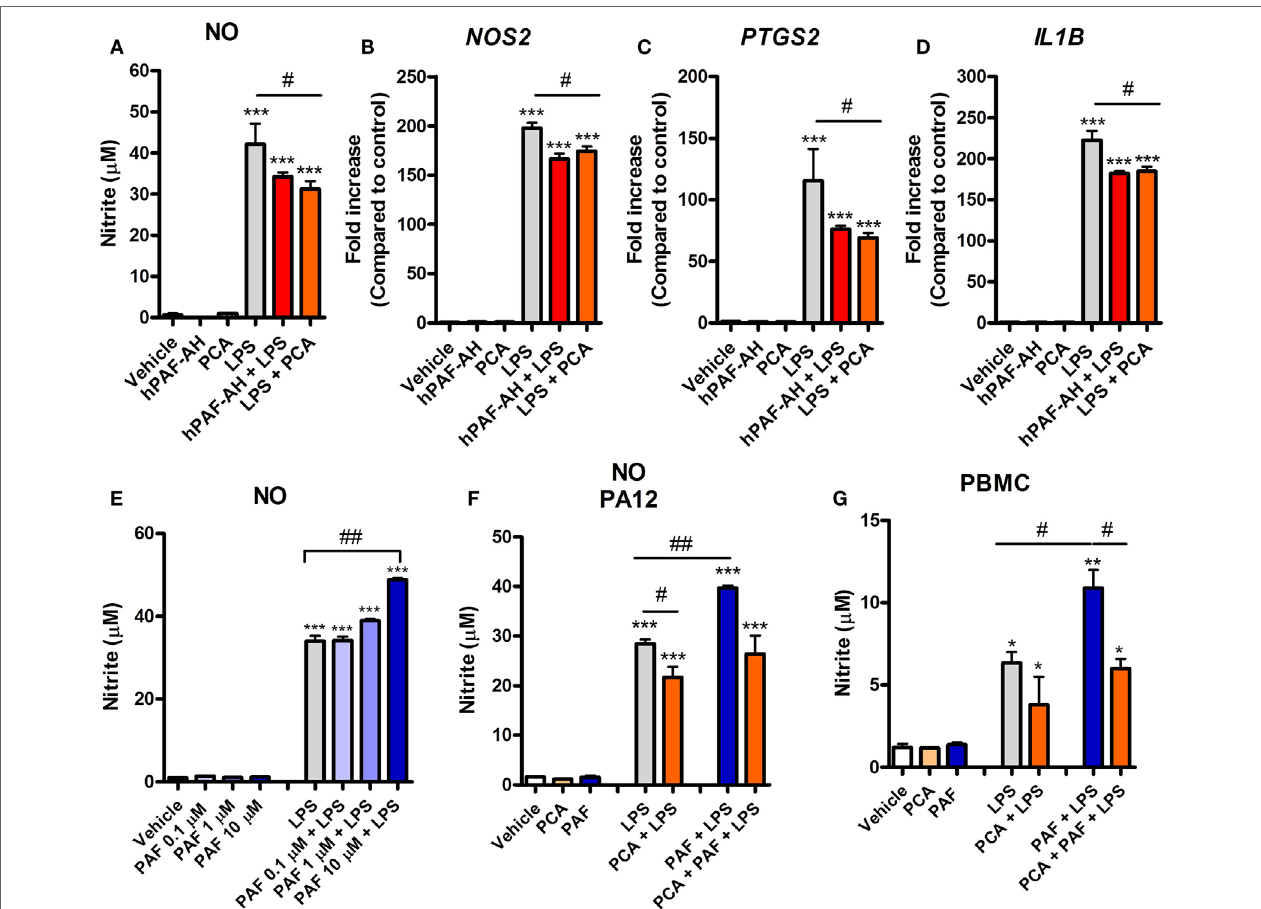
FigUre 4 | Endogenous platelet-activating factor (PAF) contributes to the pro-inflammatory response elicited by lipopolysaccharide (LPS) and exogenous PAF potentiates LPS-induced inflammation in chicken primary macrophages. After stimulation with E. coli LPS (10 ng/ml) in the presence or absence of PCA 4248 (10 µM) or human PAF-acetylhydrolase (PAF-AH) (10 µg/ml) for 6 h, B13/B13 histocompatible chicken-derived bone marrow-derived macrophage (BMDM) supernatants were assessed for the presence of (a) nitric oxide (NO), and cell lysates were used to analyze gene expression of (b) iNOS/ NOS2 , (c) COX-2/ PTGS2 , and (D) IL-1 β / IL1B by quantitative real-time PCR. Data are expressed as relative normalized expression (as compared to vehicle control group). (e) PAF (0.1–10 µM) alone or together with LPS was added to BMDM, and NO production in the supernatants was assessed after 6 h. (F) NO production by BMDM derived from the bone marrow of the outbred PA12 chickens following exposure to PAF (10 µM) and/or LPS in the presence or absence of PCA 4248 (10 µM) for 6 h. (g) NO production by peripheral blood mononuclear cells (PBMC) from B13/B13 histocompatible chickens following exposure to PAF (10 µM) and/or LPS in the presence or absence of PCA 4248 (10 µM) for 6 h. Values are mean ± SEM. * P < 0.05, ** P < 0.01, and *** P < 0.001 when compared to negative (vehicle) control groups. # P < 0.05 and ## P < 0.01 when compared to positive control